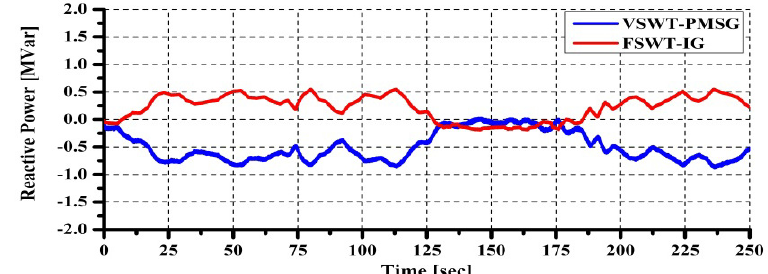
Figure 32. Reactive power output of wind generators.